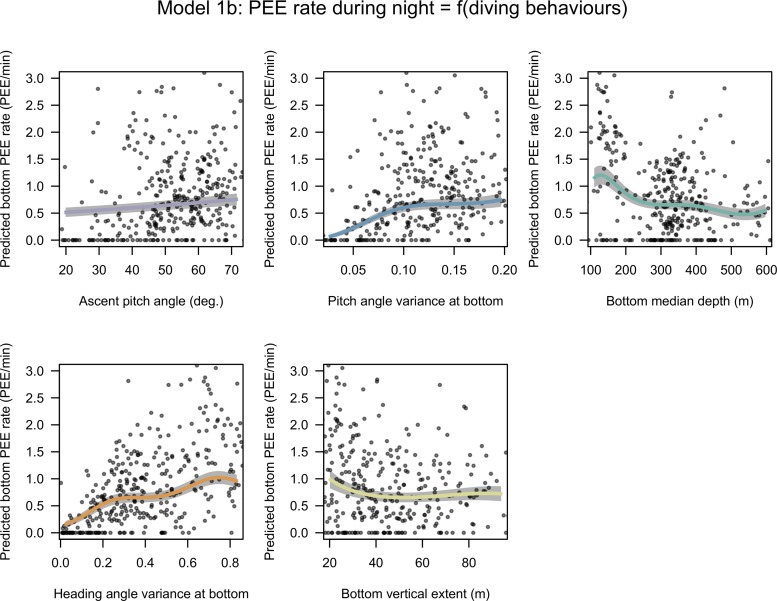
Estimated effects of covariates selected in model 1b.The predictions for each covariate varying from the 5% to the 95% quantile of observed values with other covariates at their mean. The x axes have been scaled to range from -2 to 2 normalized so that regression slopes are comparable but are annotated with raw units so that units are comprehensible. The grey shades around the regression lines indicate the standard error of the mean prediction estimates.